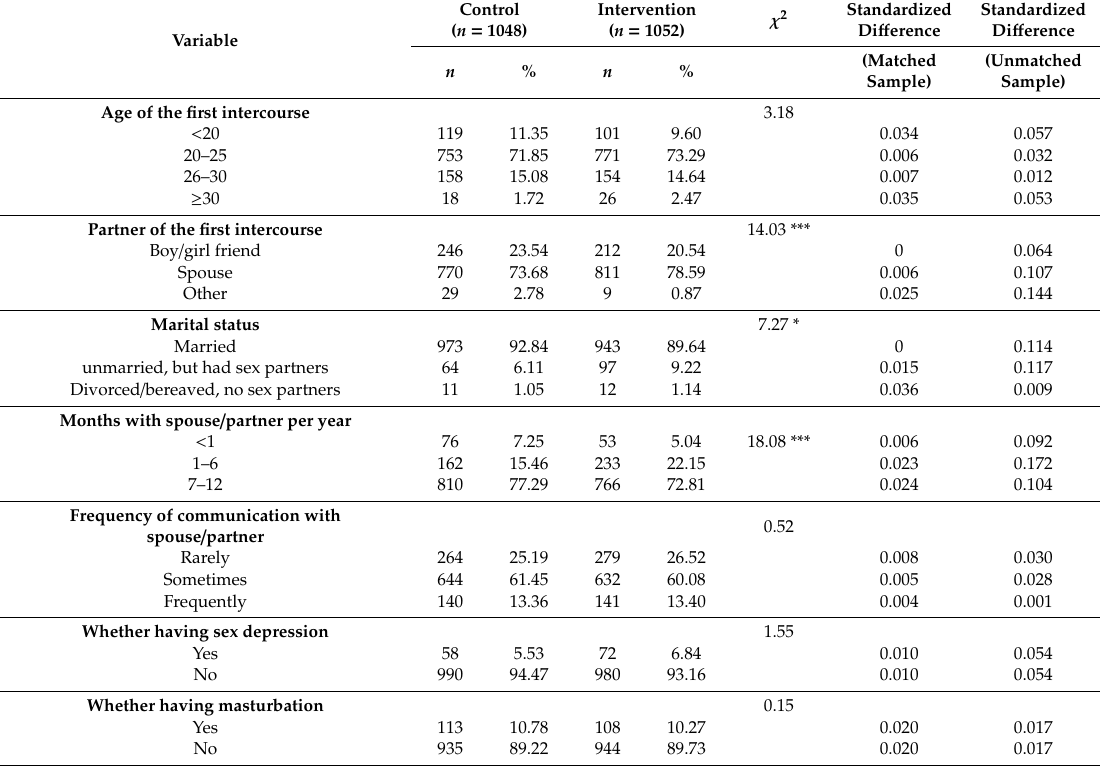
Table A5. Comparison of sexual and marital characteristics among participants between intervention and control groups in Beijing ( n = 2100).